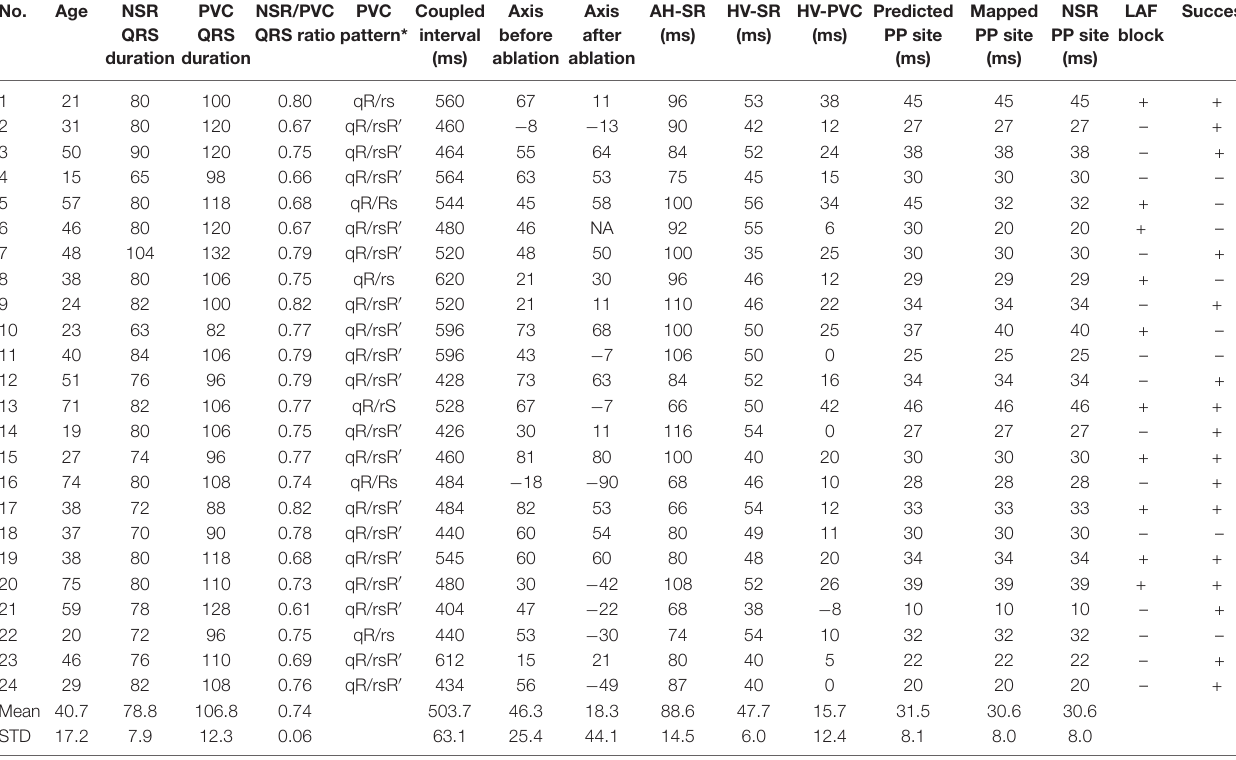
TABLE 2 | Electrophysiological characteristics and follow-up result after the index ablation procedure.